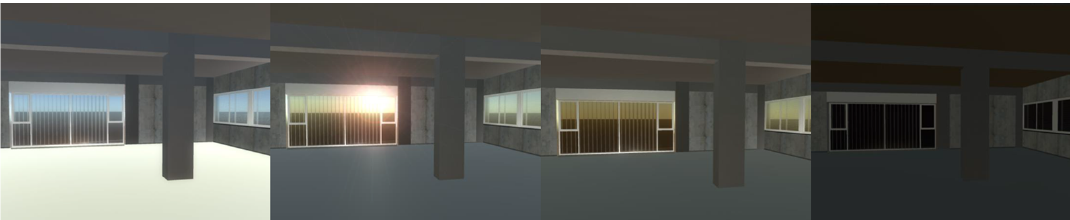
Figure 9. Lighting, which can carry associated risks such as changes in light, from glare to darkness, hindering adequate visibility.